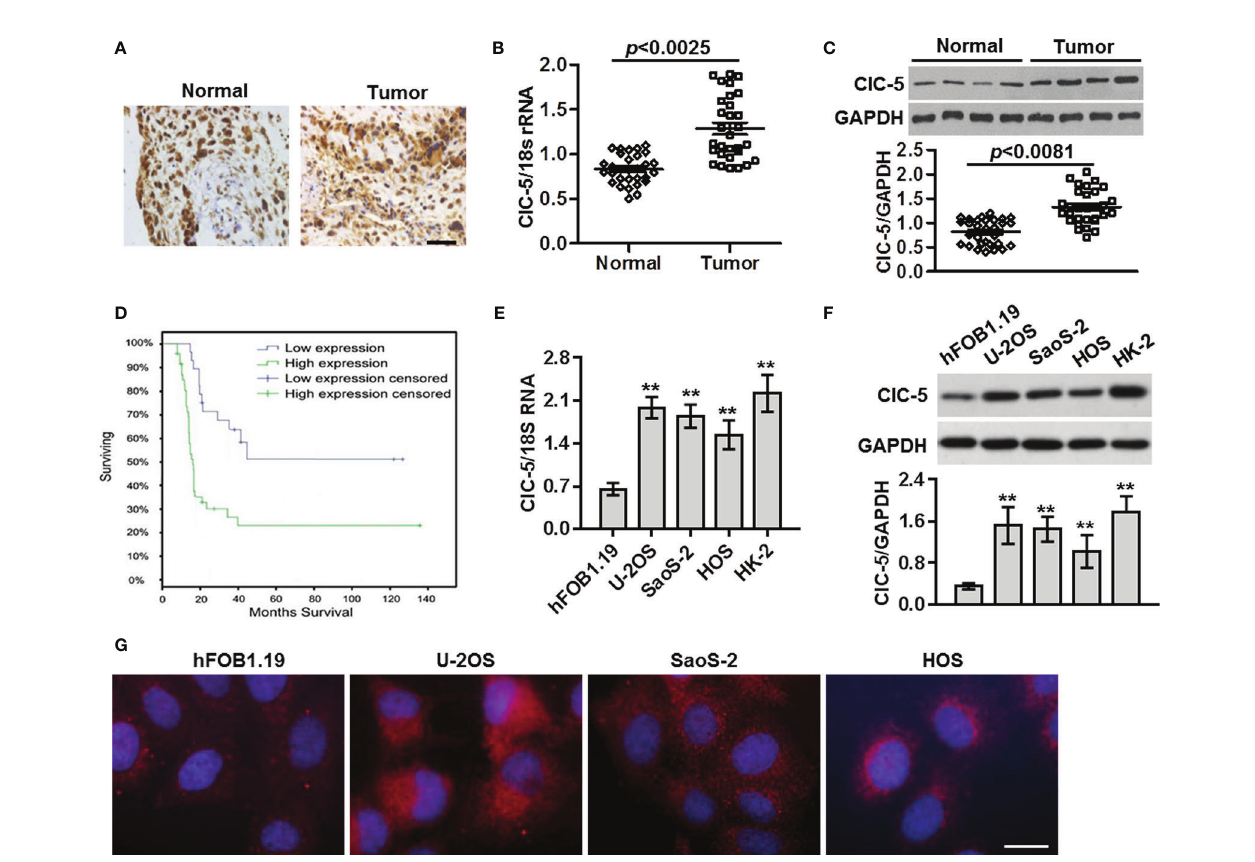
FIGURE 1 | ClC-5 expression is increased in osteosarcoma tissues. (A) Paraf fi n-embedded sections of normal bone tissues and osteosarcoma tissues were collected. Expression of ClC-5 was detected by immunohistochemistry. Scale bar, 100 m m. (B) Real-time PCR analysis to quantify the endogenous expression of ClC-5 in normal bone tissues (n = 30) compared with osteosarcoma tissues (n = 30). (C) ClC-5 protein expression was determined by Western blotting and quantitative results of ClC-5 expression were presented. (D) Correlation of ClC-5 expression and overall survival in patients with osteosarcoma cancer. Observations were censored at trial discontinuation for reasons other than death or at trial completion. (E, F) The ClC-5 expression in human normal osteoblasts hFOB1.19, osteosarcoma cell lines U-2OS, SaoS-2, and HOS, and renal proximal tubule epithelial HK-2 cells was determined by real-time PCR (E) and western blotting (F) . **P < 0.01 vs. hFOB1.19 cells, n = 6. (G) Representative images of ClC-5 distributions in osteoblast and osteosarcoma cells. N = 4. Scale bar, 20 m